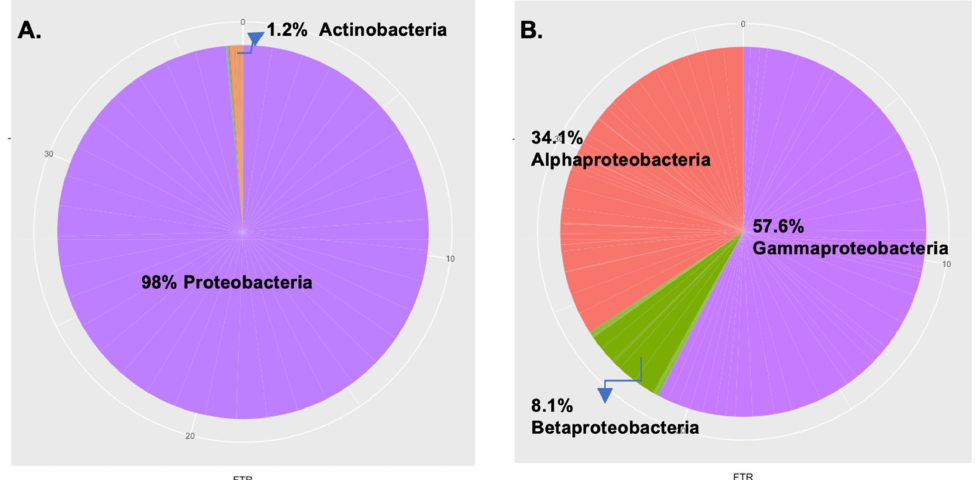
Figure 3. Proportion of the specific blood microbiota. The pie charts given here represent the relative abundance of the ( A ) phylum and ( B ) class level distribution of the most dominant phylum of proteobacteria in all the participants.